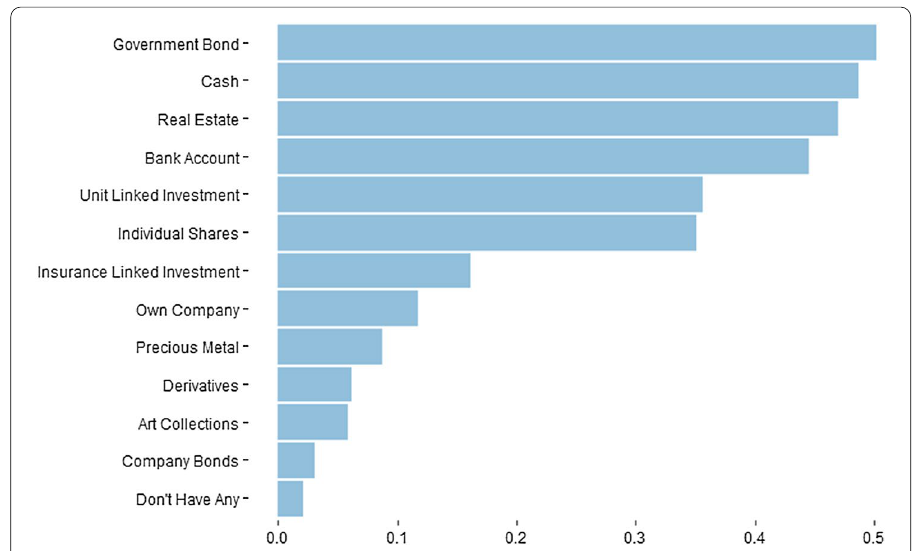
Fig. 4 Current investment portfolio of